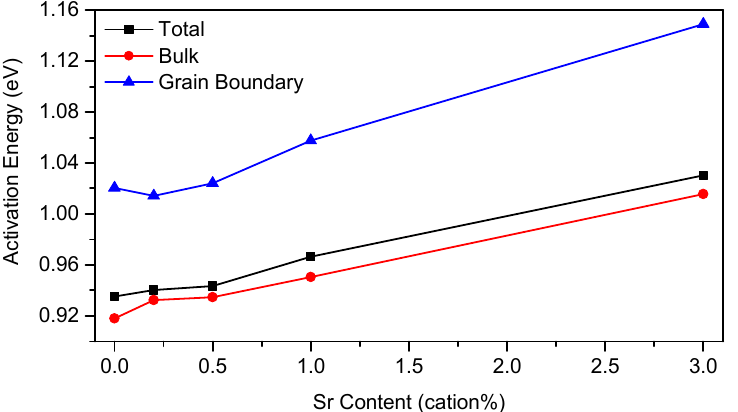
Figure 9. Plots of activation energy as a function of Sr content for total, bulk and grain boundary ionic conductivity of Ce 0.8 − x Sm 0.2 Sr x O 2 − δ samples.